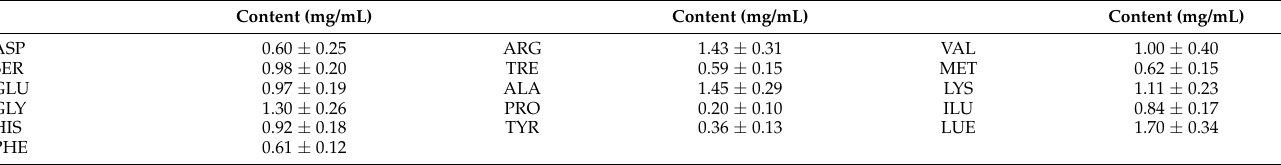
Table 1. Amino acid contents in EPPH